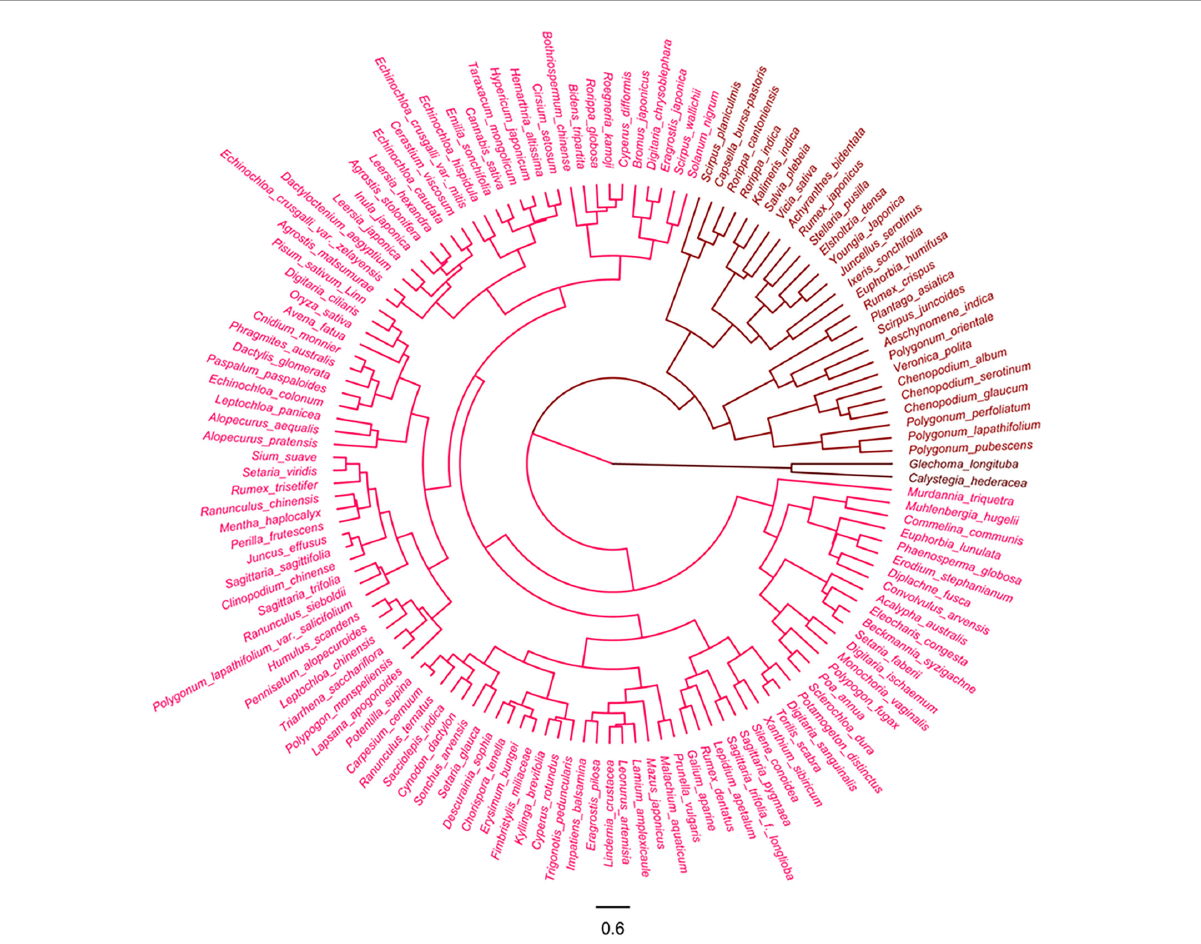
FIGURE3 Cluster analysis of farmland weeds based on color of pre- and post-stained seeds/fruits. Red color indicates visibility of stained seeds from visible to invisible.